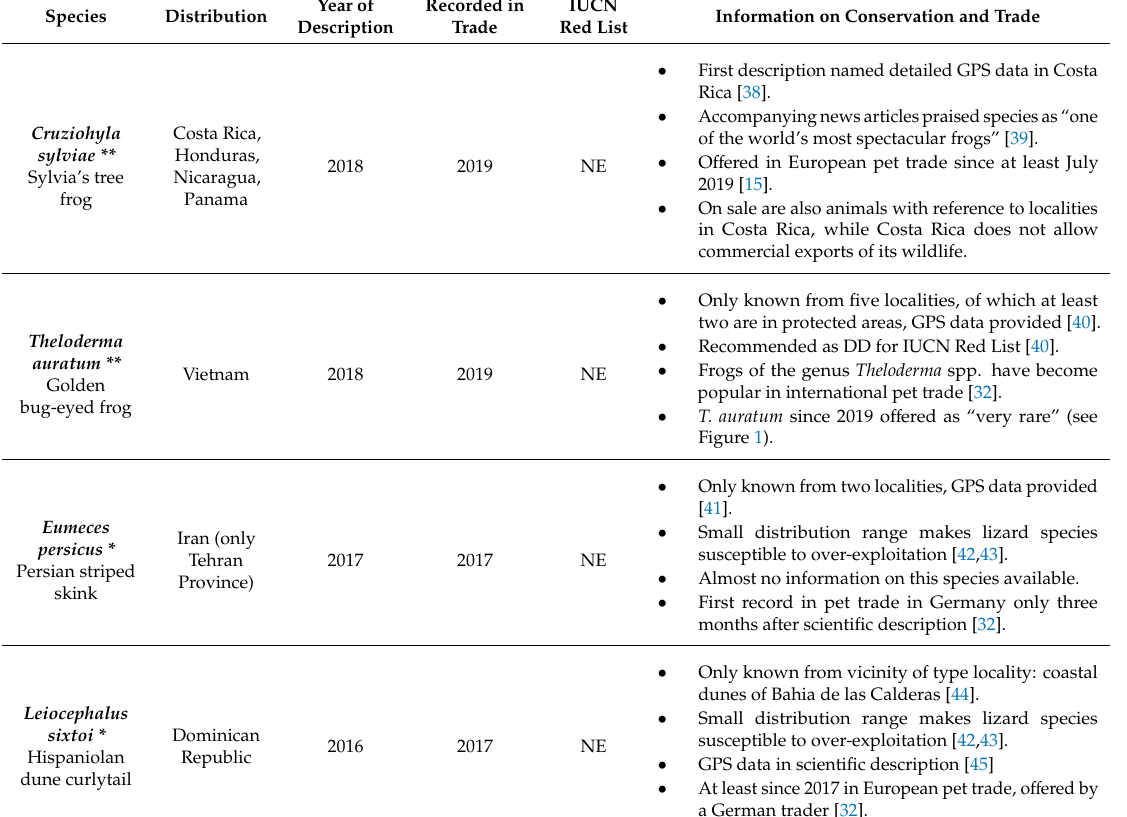
Table1. Casestudiesofrecentlydescribedreptileandamphibianspecies. Sortedby“Yearofdescription”. IUCN Red List classifications: CR = Critically Endangered; EN = Endangered, VU = Vulnerable, DD = Data Deficient, NE = Not Evaluated. AOO = Area of Occupancy. Species of dataset 1 are marked with *, species of dataset 2 with